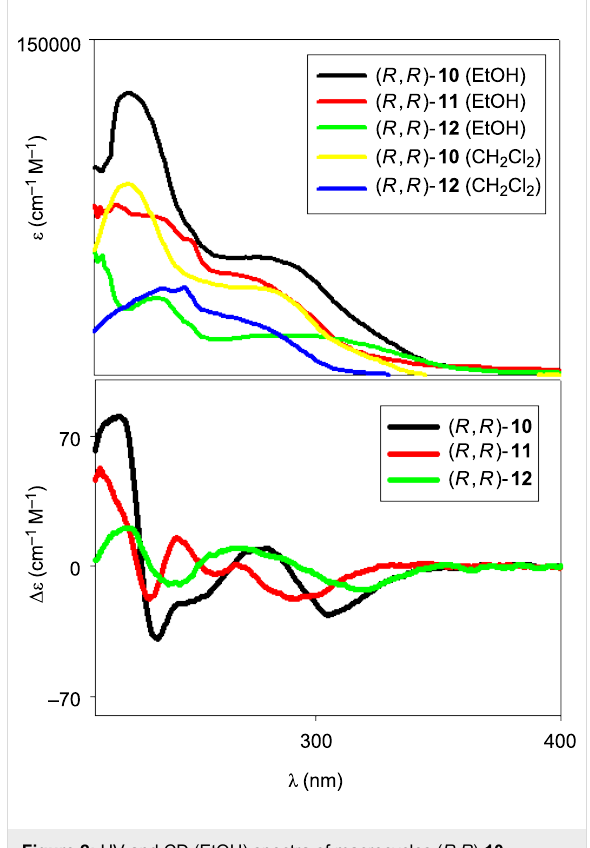
Figure 2: UV and CD (EtOH) spectra of macrocycles ( R , R )- 10 , ( R , R )- 11 and ( R , R )- 12 in the range 220–400 nm.